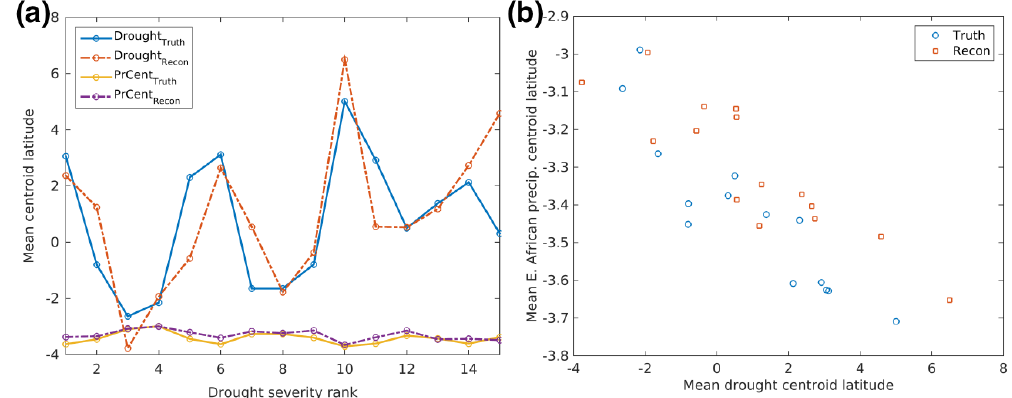
Figure 10. The latitude locations of the zonal mean multiyear drought and precipitation centroids (PrCent) for both the truth and the reconstruction over equatorial East Africa. Panel (a) shows the centroid locations as a function of drought severity rank, while panel (b) has the same information but more clearly shows the negative correlation between the locations of drought and precipitation